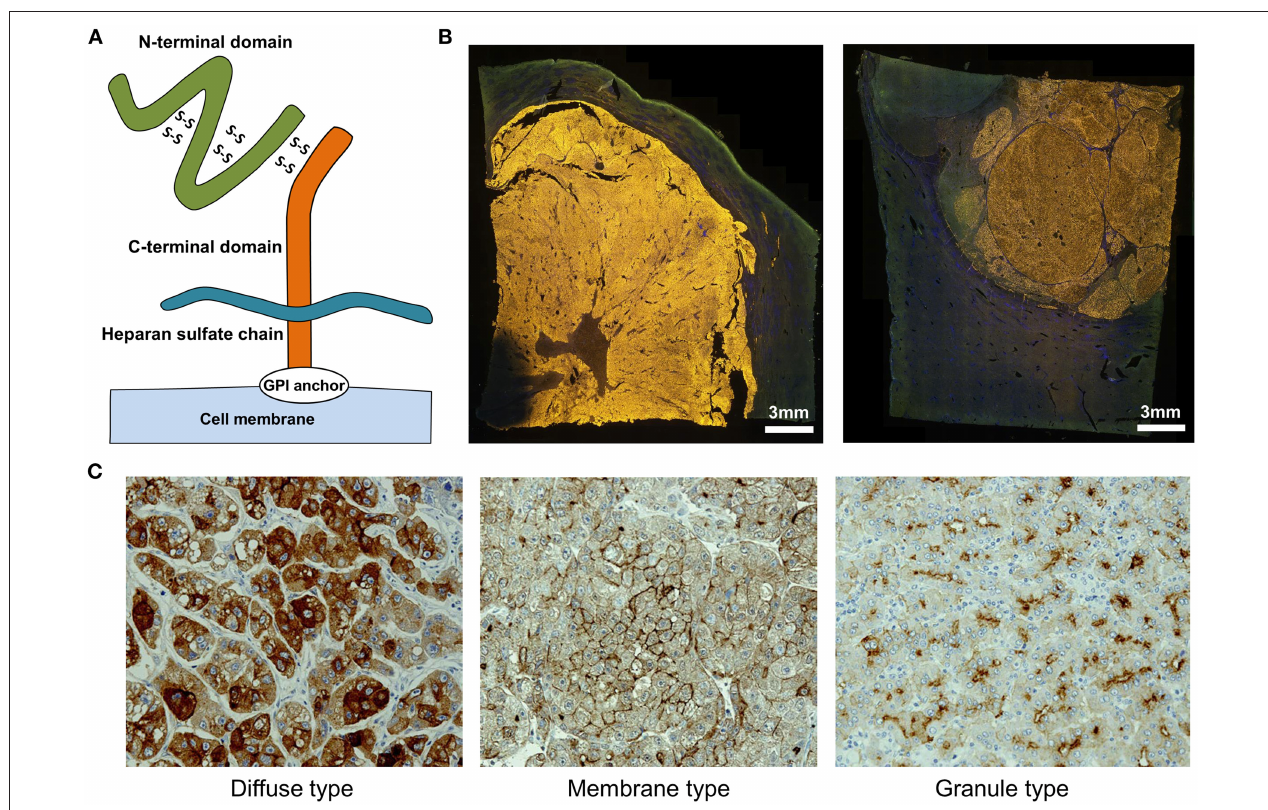
FIGURE 1 | Characteristics of GPC3. (A) Schema of GPC3. (B) Fluorescence micrographs of GPC3-positive HCC. GPC3 labeling appears as a yellow color. (C) GPC3 expression patterns can be classified into diffuse, membrane, and granule types by immunohistochemistry. peptides plus IFA as cancer vaccines in clinical trials and observed that stronger immune responses were induced by varying peptide